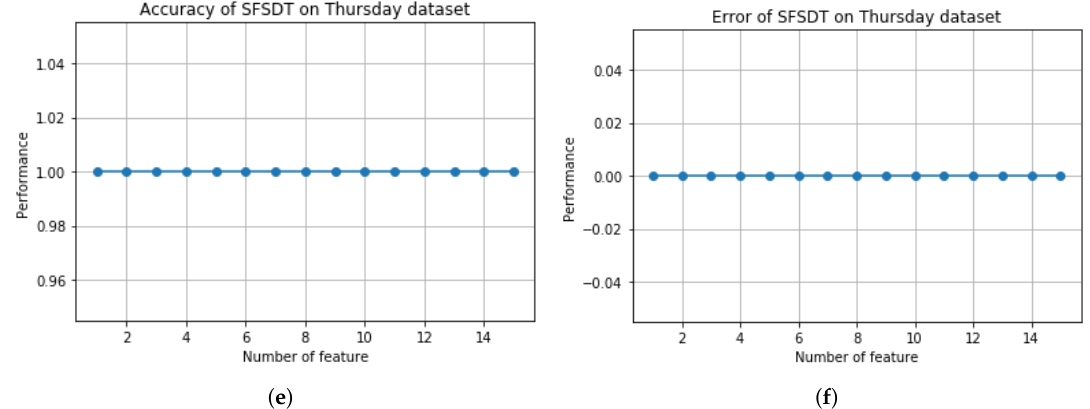
Figure 11. Visualization accuracy and error scores of SFSDT model on each day of ISCX dataset. ( a ) & ( b ) Tuesday data; ( c ) & ( d ) Wednesday data; ( e ) & ( f ) Thursday data.